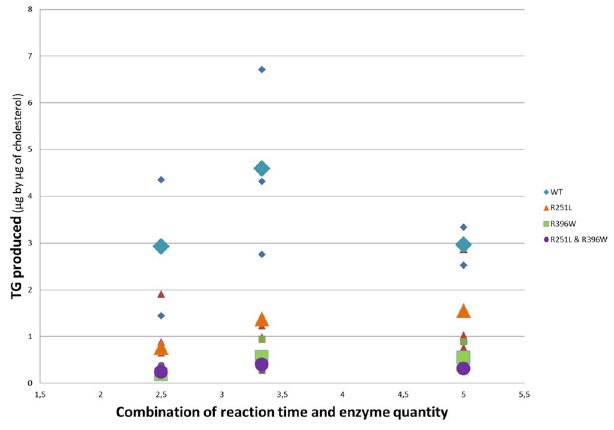
Figure 6. Quantity of triglyceride produced in each combination of reaction time and enzyme quantity for the four DGAT1 constructs: wild type, with the R251L mutation, with the R396W mutation, and with both mutations. This quantity of triglyceride has been corrected by an internal standard (TG19) and by the amount of measured cholesterol. The small symbols correspond to individual measurements and the large symbols are the mean of the corresponding